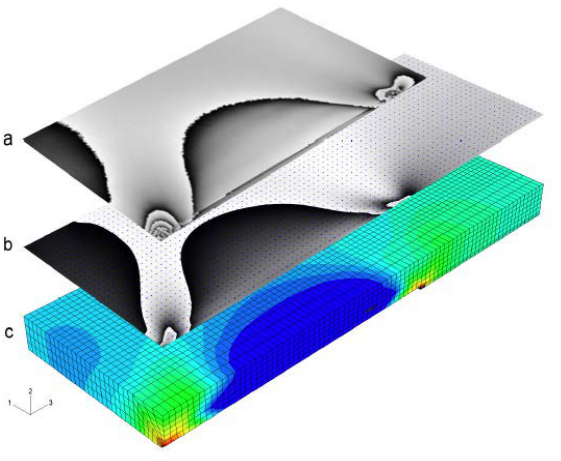
Fig. 8 Experimental (a), simulated phase image (b), stress plot of a FE simulation (c) (Deuschle